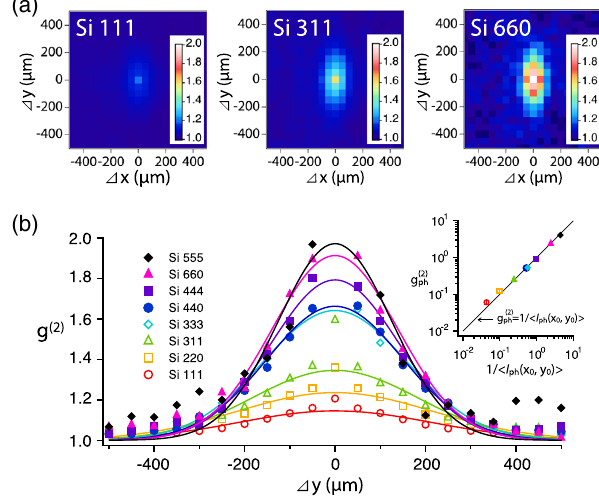
FIG. 2. (a) g ð 2 Þ of the x-ray beam monochromatized by Si flat crystal in a reflective index of 111, 311, or 660. (b) Line profiles of g ð 2 Þ ð Δ x ¼ 0 μ m ; Δ y Þ and their fitted results by Gaussian functions. Inset: degree of the effect of photon shot noise on intensity interference as a function of the reciprocal of average number of detected photons at the pixel corresponding to the center of the monochromatized x-ray